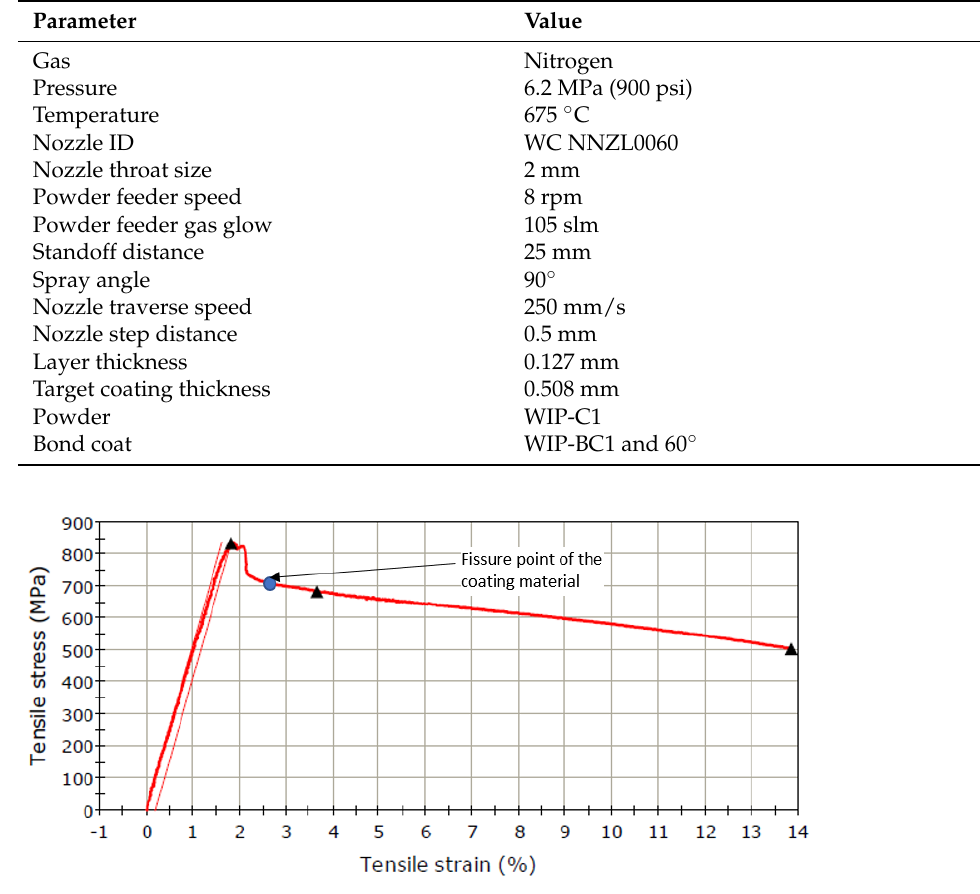
Figure 3. Characteristic stress-strain curve, specific to a coated sample.